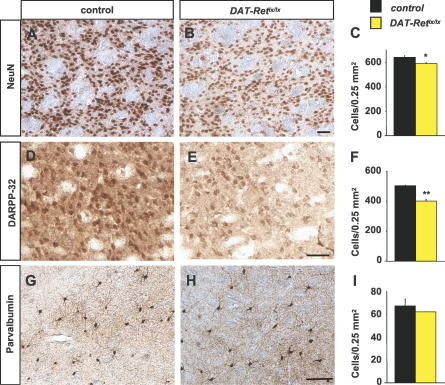
Loss of Postsynaptic Target Cells but Not Local Striatal Interneurons in DAT-Retlx/lx MiceImmunohistochemical stainings of dorsal striatum of 2-y-old control (A, D, and G) and DAT-Retlx/lx mutants (B, E, and H) for NeuN (A and B), DARPP-32 (D and E), or parvalbumin (G and H). Histograms showing the number of NeuN-positive (C), DARPP-32–positive (F), and parvalbumin-positive cells (I) in DAT-Retlx/lx mutants and age-matched controls (n = 3–5 each genotype). Note also the reduced staining intensities for NeuN and DARPP-32 in DAT-Retlx/lx compared to control mice. *, p < 0.05; **, p < 0.01 (Student t-test). Scale bars indicate 50 μm.